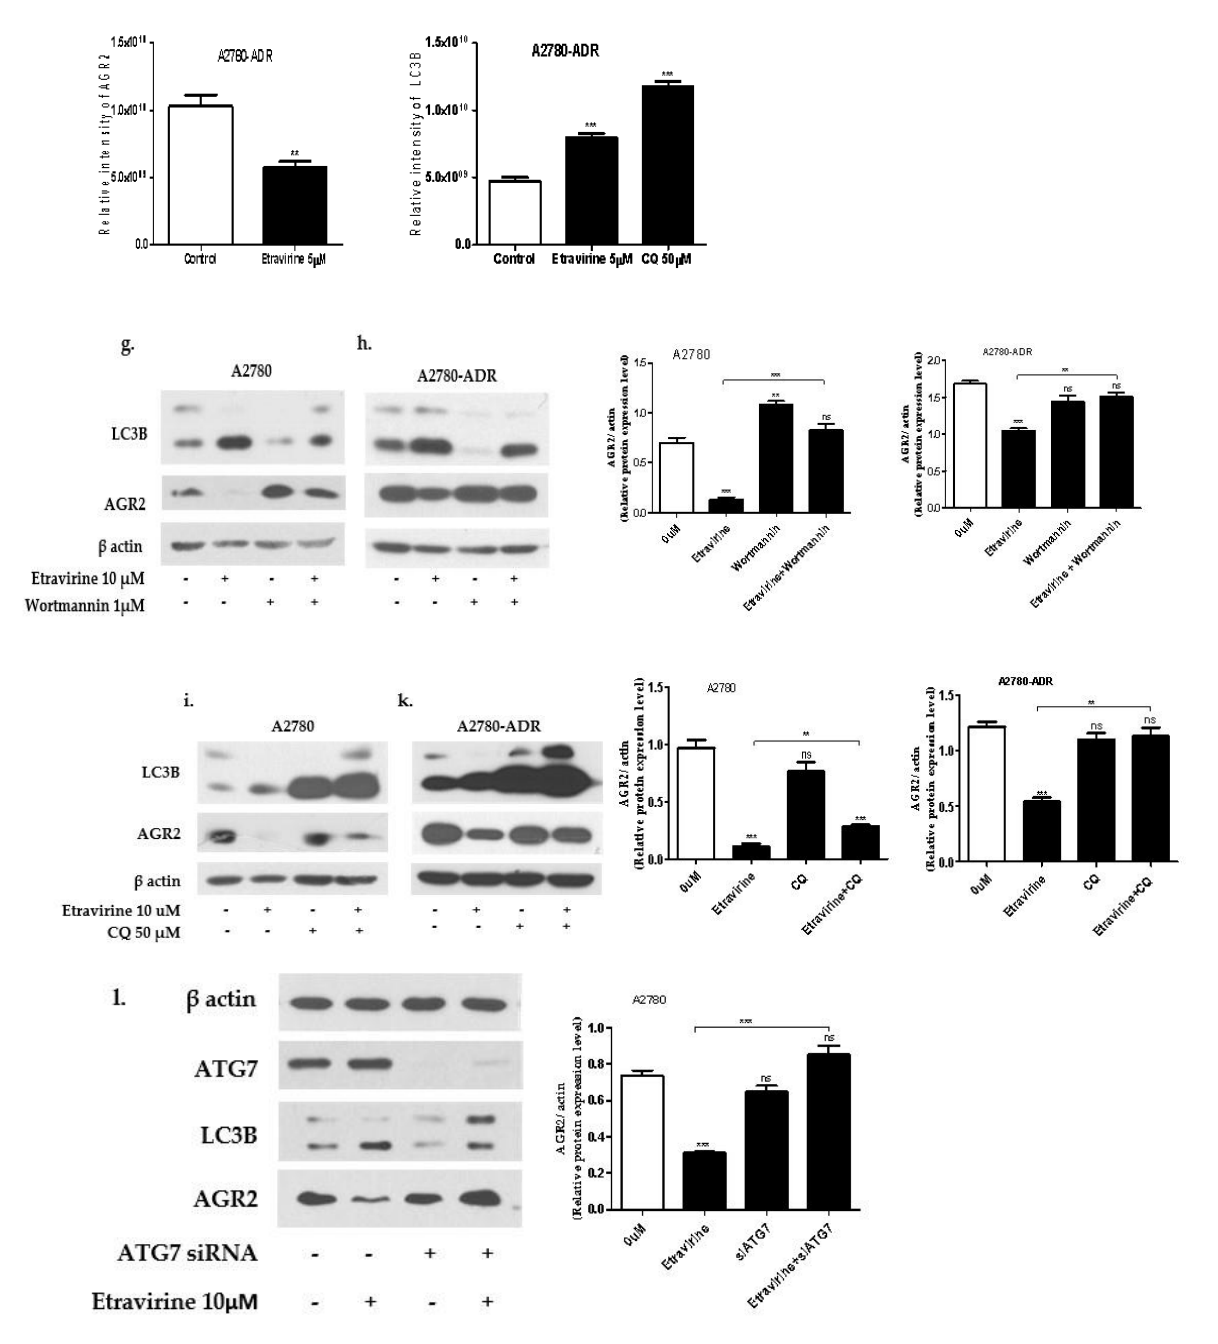
Figure 1. Etravirine induces AGR2 degradation by autophagy. ( a – d ) Western blot analysis showed the effect of etravirine on AGR2 expression and LC3B expression. ( e , f ) Immunofluorescence analysis showed the expressions of AGR2 and LC3B in A2780-ADR cells after treatment with 5 µ M etravirine for 48 h and 50 µ M CQ for 24 h by using Lion Heart FX automated microscope (40 × ). Scale bar 100 µ m. ( g , h ) A2780 and A2780-ADR cells were exposed with wortmannin (PI3K inhibitor) 1 µ M for 24 h prior to etravirine 10 µ M for 72 h. ( i , k ) A2780 and A2780-ADR cells were pretreated with 50 µ M CQ for 24 h and then treated with 10 µ M etravirine for 72 h. ( l ) Knockdown of ATG7 by 100 nM siRNA for 72 h in A2780 cells and then treated with etravirine 10 uM for 72 h, AGR2 and LC3B expression were detected by Western blot. Data are shown as mean ± SEM. * p < 0.05, ** p < 0.01, *** p < 0.001.